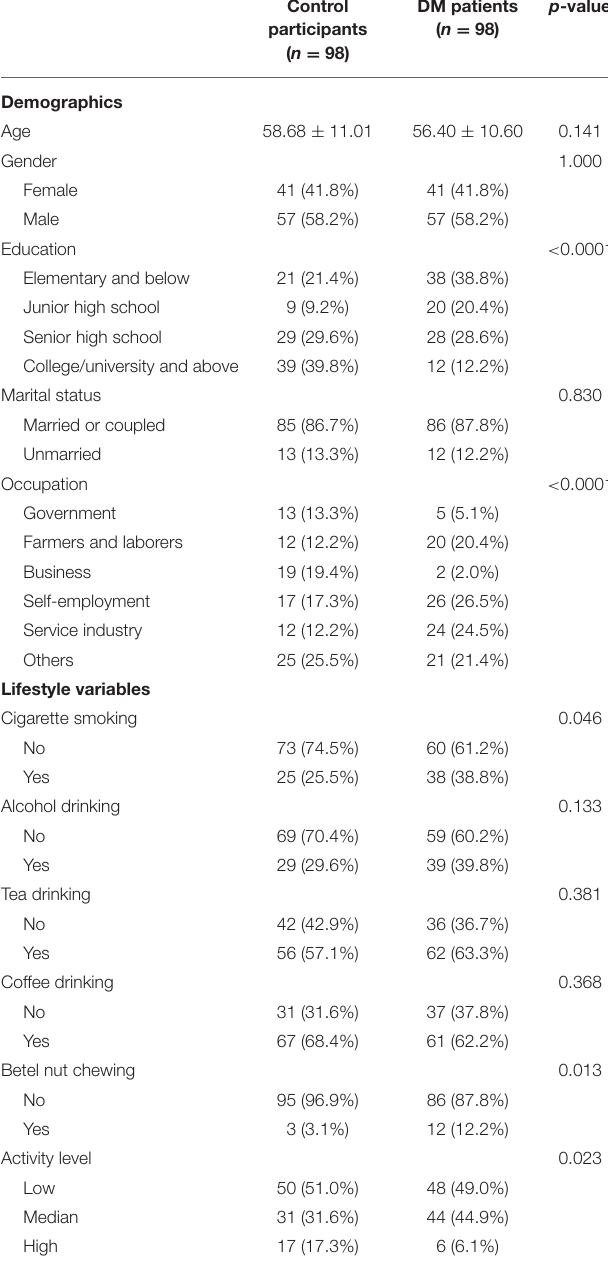
TABLE 1 | Sociodemographic and lifestyle variables of the study